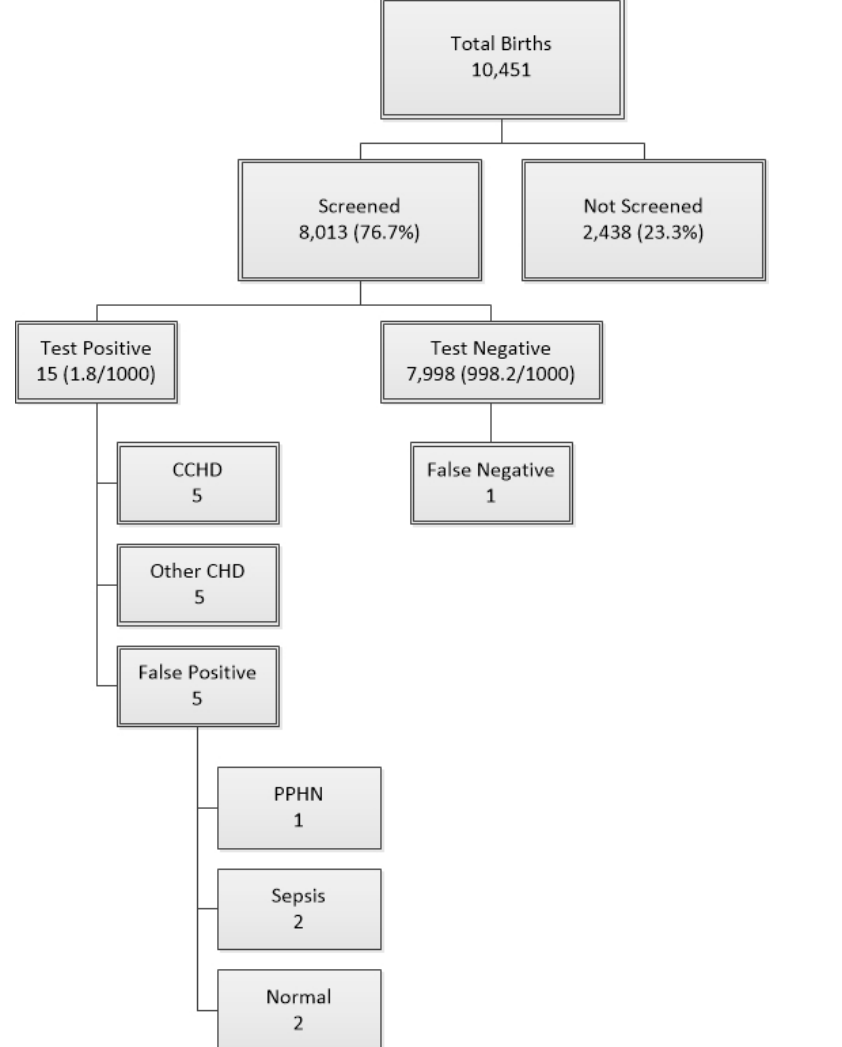
Figure 1. Distribution of the newborns enrolled in the study. 10,451 newborns were enrolled in the study among them 8013 newborns were screened for CCHD, and 2438 newborns were not tested. 15 babies (1.8/1000) failed the screening (test positive): among them, 5 CCHD were diagnosed, 5 non-critical CHD, and 5 false positives: 1 PPHN, 2 sepsis, and 2 normal hearts. CCHD: critical congenital heart disease; CHD: congenital heart disease; PPHN: persistent pulmonary hypertension of the newborn. We had an equal distribution of newborns of rural origin 51% (4086 cases) and urban origin in our study, 329 cases (4.1%) were from gestational diabetic mothers, 247 of the mothers (3.08%) had preeclampsia, and 40 of them had other chronic pathologies (0.5%) (e.g., dysthyroidism, psychiatric